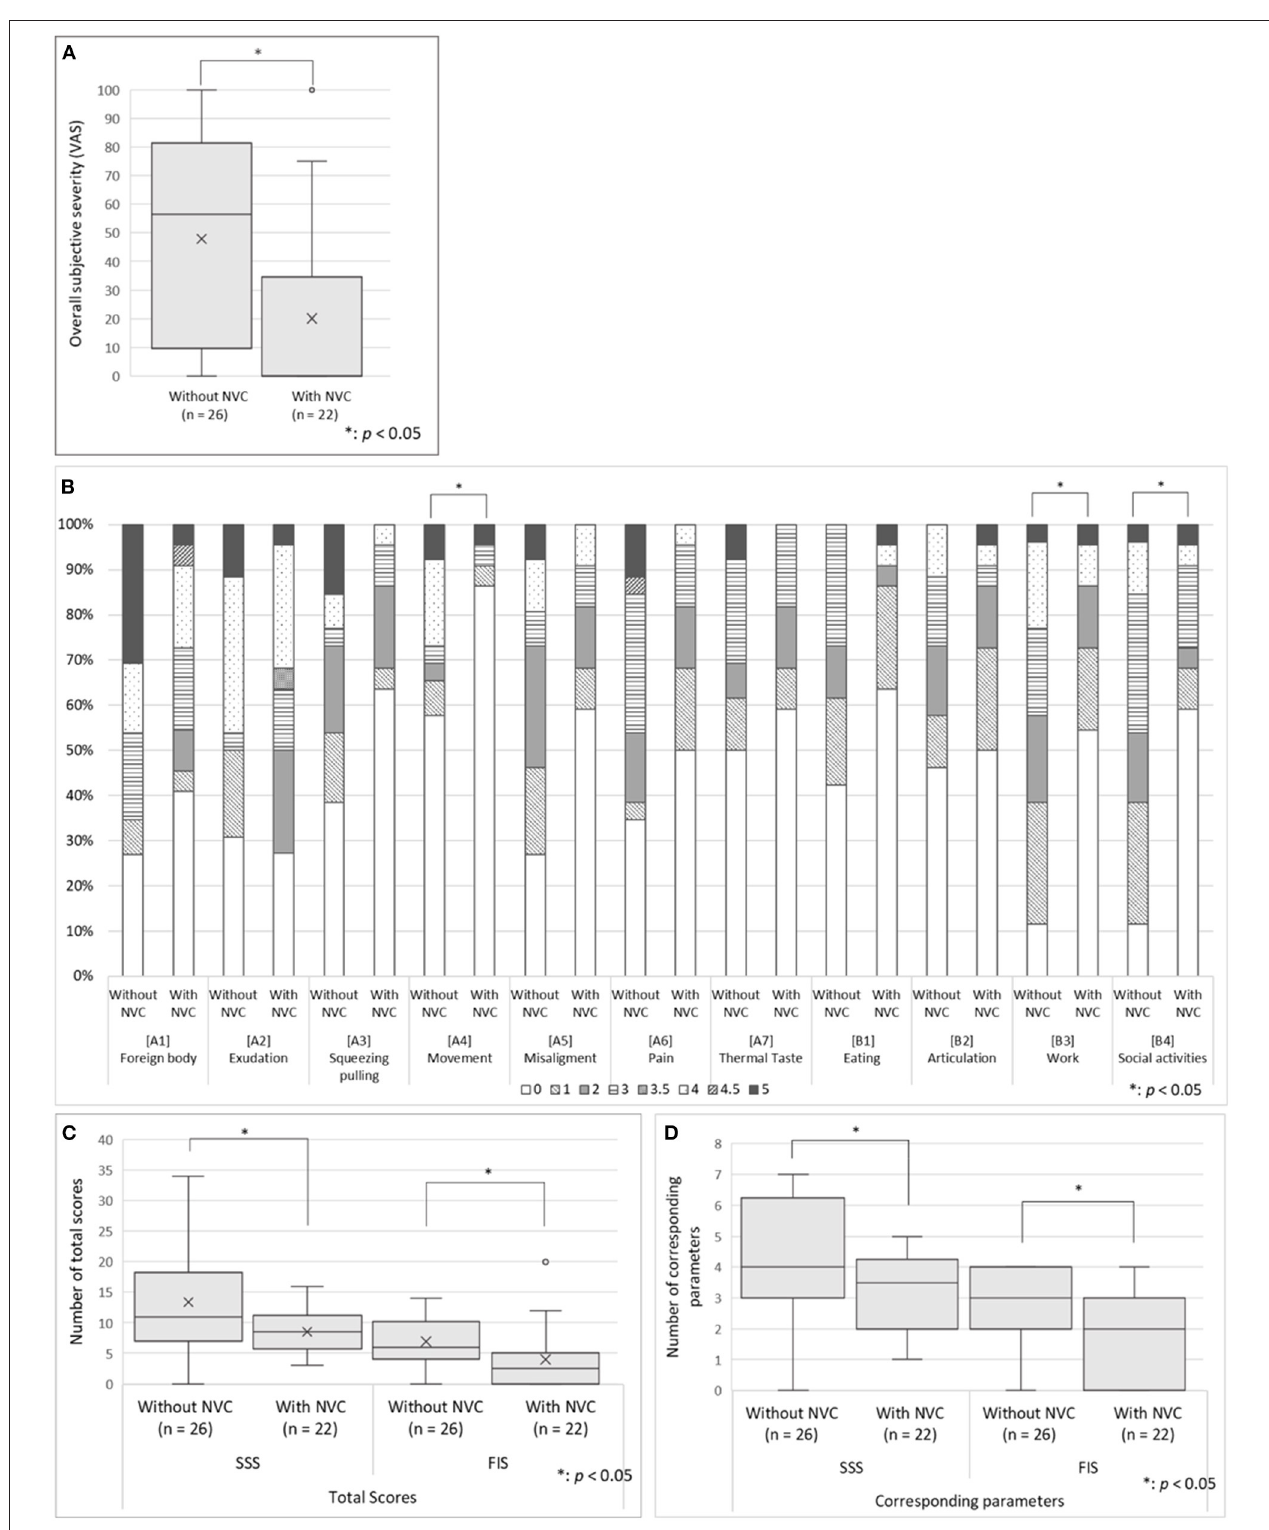
FIGURE 3 | The oral DRS scores in the patients having predominantly unilateral OC with and without NVC. (A) The overall subjective severity of OC symptoms: The patients without NVC presented significantly higher VAS scores that indicate overall subjective severity of OC symptoms according to Student’s t -test. (B) The